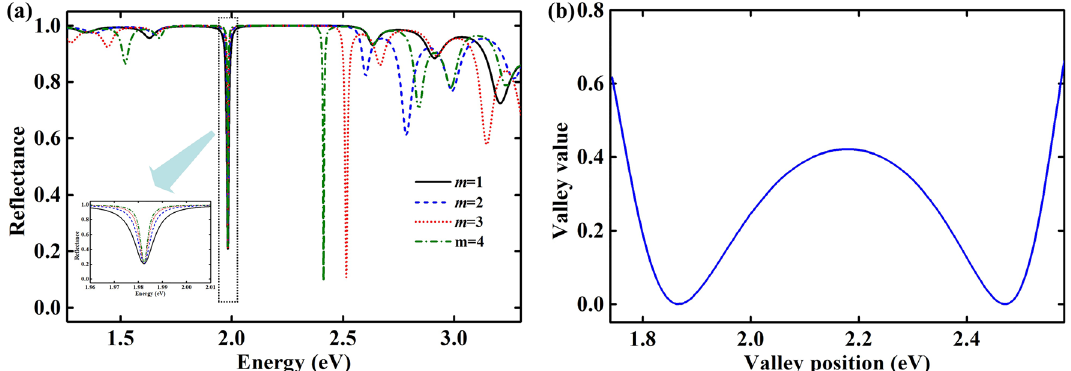
Figure 5. ( a ) Reflectance spectra of TP mode at 1.9824 eV for different orders. The subgraph is the reflectance spectra near 1.9824 eV. ( b ) Dependence of valley value on valley position for TP